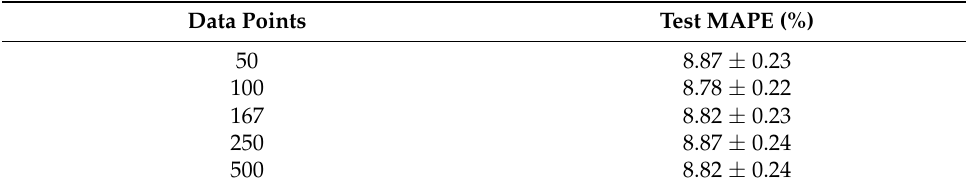
Table 4. Test MAPE using subject normalization over raw data depending on the number of data points of the YBT excursions.